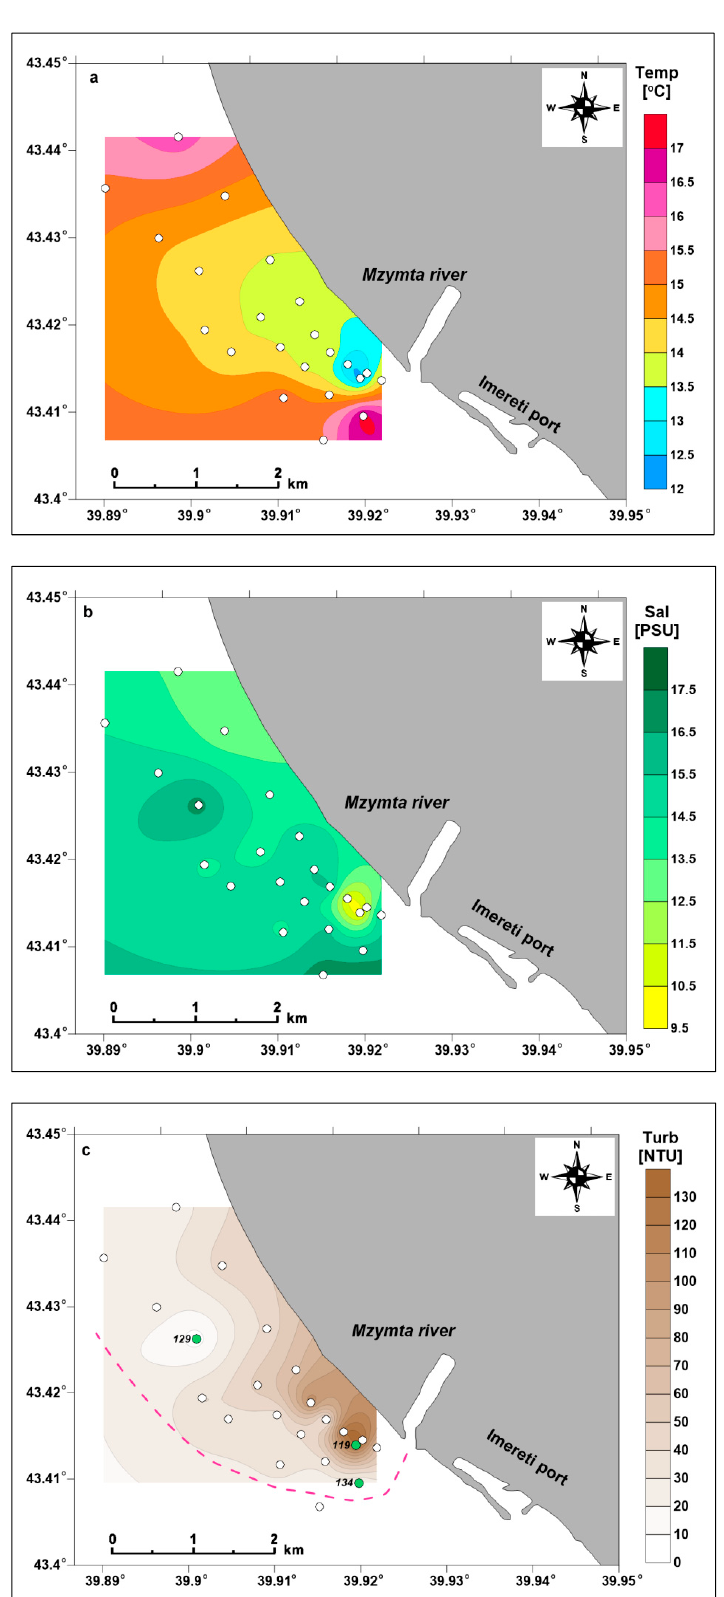
Figure 4. Maps of spatial distribution on 2 May 2019: ( a ) water temperature; ( b ) salinity; ( c ) turbidity from CTD and TM measurements. Pink dashed line indicates the boundary of the river